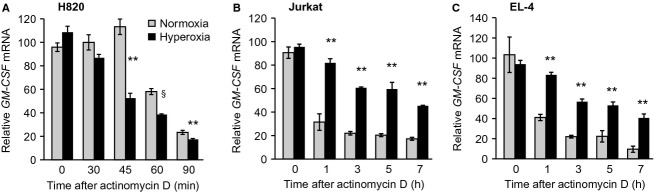
Effect of exposure to hyperoxia on GM-CSF mRNA stability. Human H820 cells (A) and PMA/A23187 activated Jurkat (B) and EL4 (C) T cells were placed in normoxia (gray bars) or hyperoxia (black bars) for 48 h, after which actinomycin D (5 μg/mL) was added to stop transcription (time 0). Relative mRNA for GM-CSF was determined at time points from 0 to 90 min (H820) or from 0 to 7 h (Jurkat and EL4) after addition of actinomycin D. mRNA levels were measured by RT-PCR and normalized to GAPDH, with zero time in normoxia considered 100%. Data are expressed as mean ± SEM, n = 3. Each experiment is representative of two independent experiments. **P < 0.01; §P = 0.033